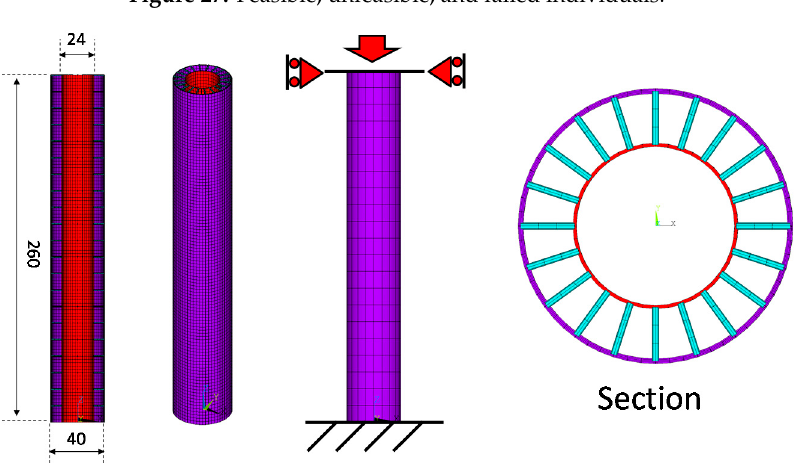
Figure 28. Test Case 3—Best design—Geometry e boundary conditions.